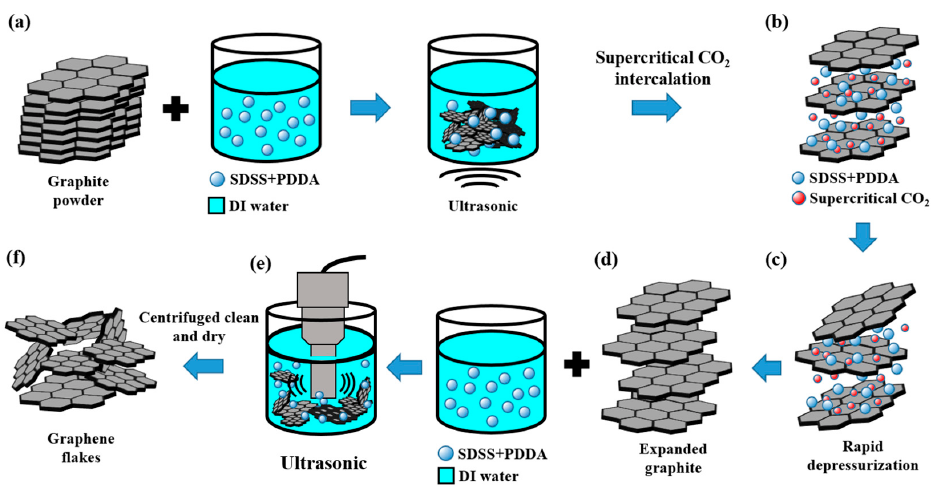
Figure 2. ( a–f ) Flow chart of preparing the GNFs using the supercritical CO 2 and surfactant treatment. ( a ) Prepare graphite solution and ultrasonically agitated. ( b ) Supercritical CO 2 intercalation. ( c ) Rapid depressurization. ( d , e ) Prepare expanded graphite solution and horn sonication. ( f ) Centrifuged clean and dry to collect graphene flakes.